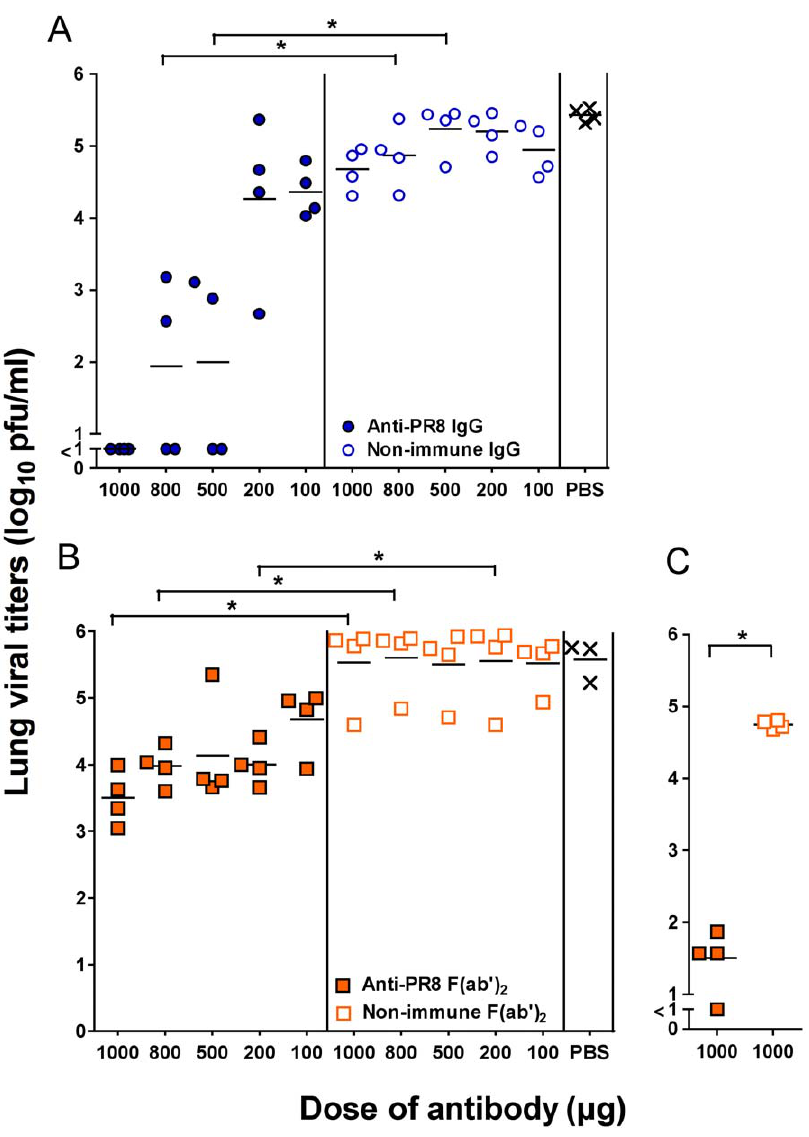
Figure 4. Virus loads are reduced in the lungs after treatment with the anti-PR8 IgG and F(ab’) 2 preparations. BALB/c mice (n=4) were infected with 50 pfu of PR8 virus in 50 m l via the TRT route under penthrane anaesthesia. Twenty four hours post-infection, mice were treated with 1000 m g, 800 m g, 500 m g, 200 m g or 100 m g of (A) anti-PR8 IgG or non-immune IgG or (B) anti-PR8 F(ab’) 2 or non-immune F(ab’) 2 or PBS via TRT route. Five days post-infection, mice were killed and lungs were collected in 1 ml media. (C) Mice were infected and treated as in (B) and lungs sampled 7 days post infection. Viral titres were determined by plaque assay on MDCK cell monolayers. The experiment was carried out in its entirety once and results are consistent with repeat experiments on selected doses. Each symbol represents an individual mouse and the line represents the mean of each group. Brackets with an asterisk indicate a statistically significant difference (p , 0.001) between the indicated groups.